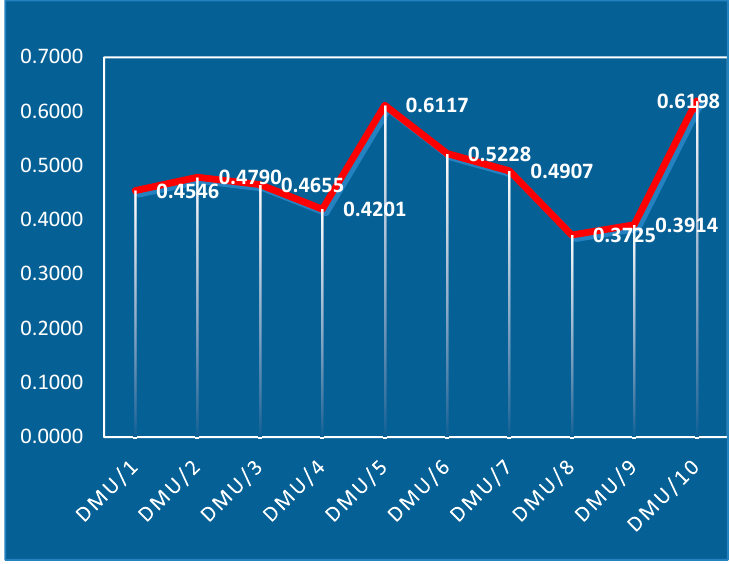
Figure 4. Final ranking score from the TOPSIS approach.